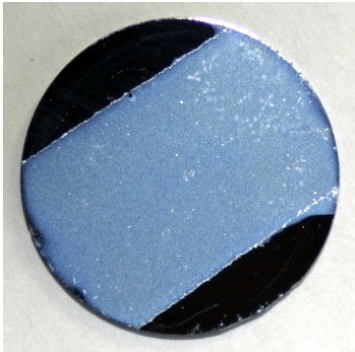
film on a Si substrate 2